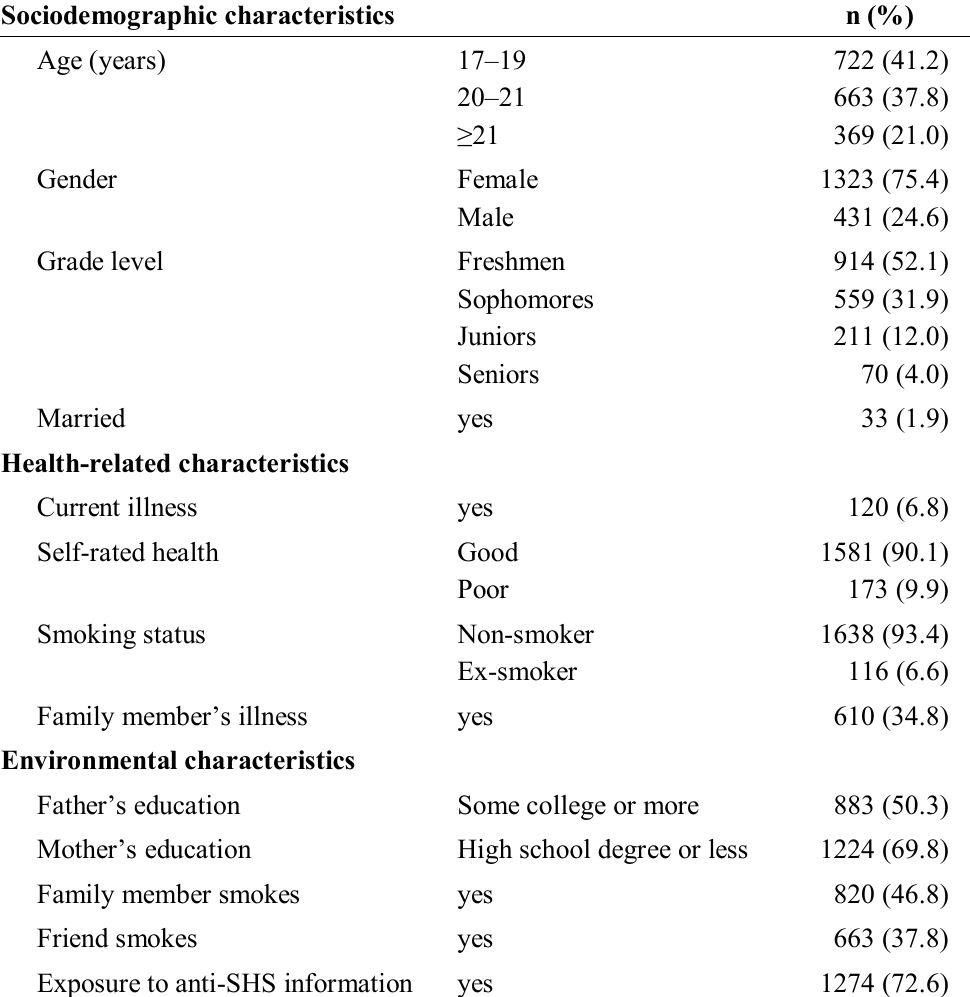
Table 1. Characteristics of the participants (n =